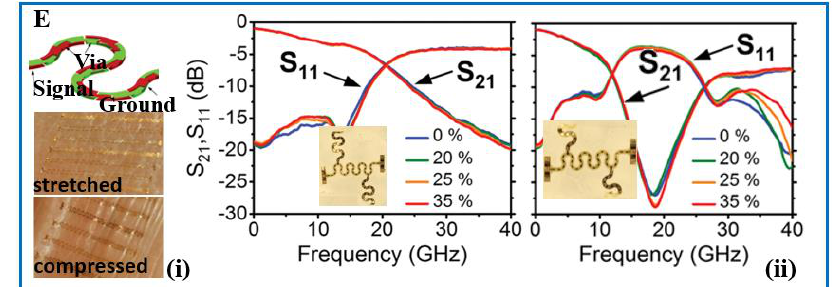
Figure 5. Stretchable antennas that exploit stretchable structures of conventional metals. ( Ai ) Return loss parameters of a fractal Vicsek curve loop antenna under different levels of tensile strain. The inset shows an optical image of an unstrained antenna fully bonded onto an elastomeric substrate. Scale bar, 4 mm. ( Aii ) Far-field profiles of the loop antenna only show a slight change in the radiation patterns at 30% tensile strain. Reproduced with permission from [92]; Copyright 2014, Nature Publishing Group. ( Bi ) Stretchable dipole antenna by converting solid radiation parts to serpentine mesh layouts. ( Bii ) The corresponding reflection curve with an increasing tensile strain. ( Biii ) Transformation of a midfield phased surface from a solid structure to a meshed stretchable layout. ( Biv ) demonstration of powering an LED with the stretchable midfield phased surface at different levels of tensile strain. Reproduced with permission from [14]; Copyright 2017, John Wiley and Sons. ( Ci ) Anatomy and location of the peripheral and epidural devices relative to the sciatic nerve. ( Cii ) Exploded view schematic illustrating the energy harvester component that includes the stretchable antenna, AC/DC converter, and an integrated LED toward wireless optogenetics. Reproduced with permission from [95]; Copyright 2015, Nature Publishing Group. ( D ) Photograph of fabricated antenna that can be mechanically reconfigured from a patch state to a monopole state. Reproduced from [101]; Copyright 2017, John Wiley and Sons. ( Ei ) Stretchable twisted-pair transmission line inspired by twisted-pair cables. ( Eii ) Scattering (S-) parameter of a stretchable low-pass filter ( left ) and band-stop filter ( right ) at a tensile strain of 0%, 20%, 25%, and 35%. The inset shows the corresponding optical image of the two filters. Reproduced with permission from [102]; Copyright 2016, John Wiley and